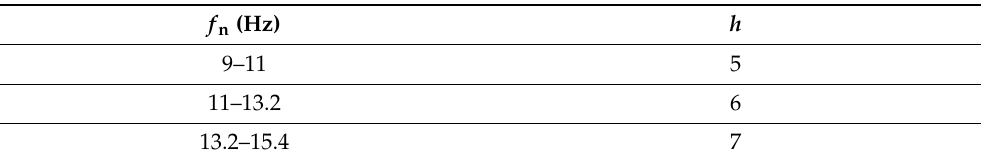
Table A5. Harmonic matching the natural frequency of high-frequency (>9 Hz) floors adopted from AISC design guide